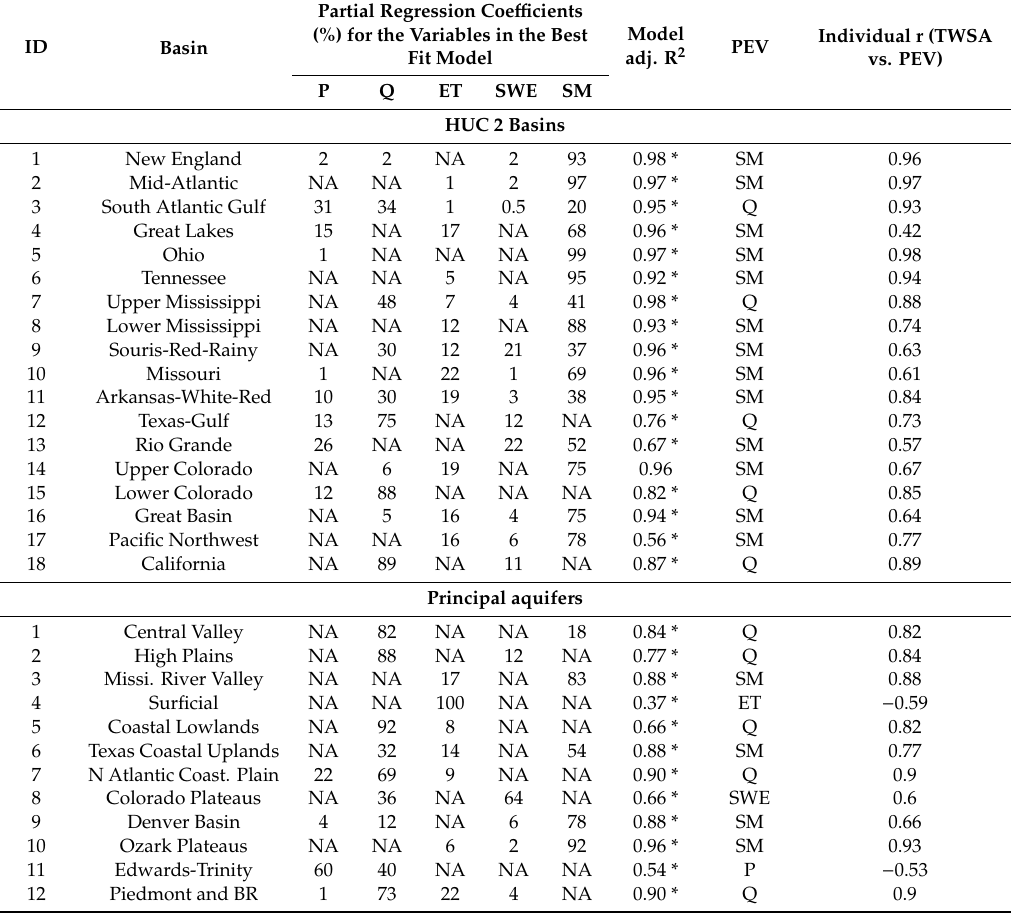
Table 3. Stepwise regression approach to identify a set of explanatory variables (Precipitation, P; Runo ff , Q; Snow Water Equivalent, SWE; Evapotranspiration, ET; and soil moisture, SM) and a primary explanatory variable (PEV) of GRACE TWSA in the